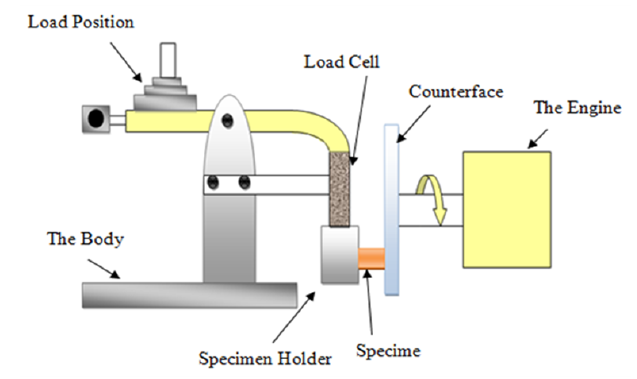
Figure 5. Tribology machine—block on desk configuration.